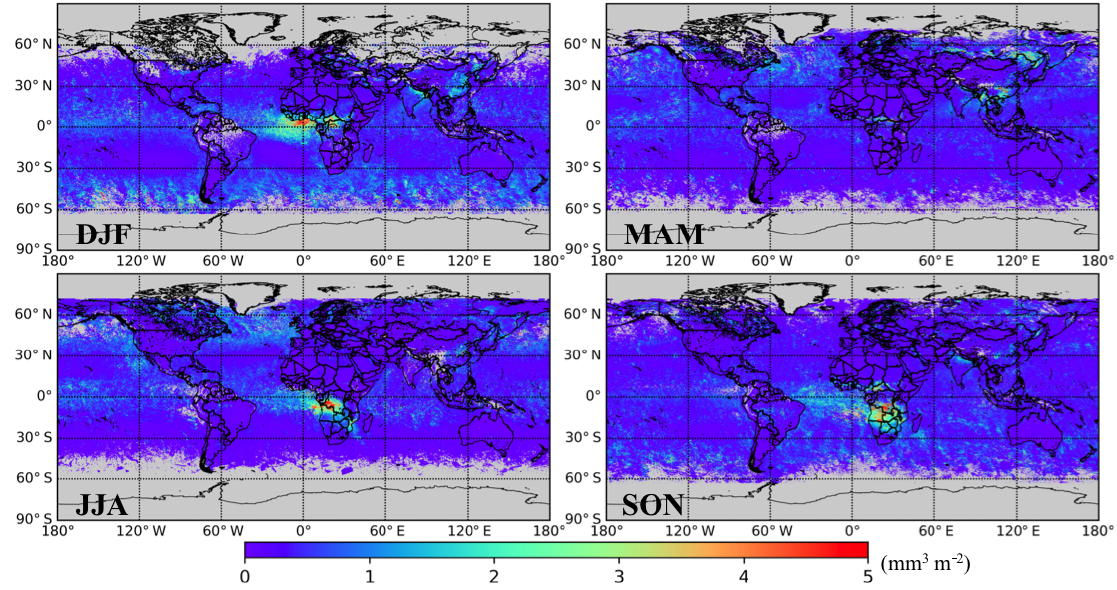
Figure 16. Seasonal variability of the BC column volume concentration (mm 3 m − 2 ) over the globe in 2008 as retrieved by the GRASP/Component algorithm from POLDER/PARASOL satellite